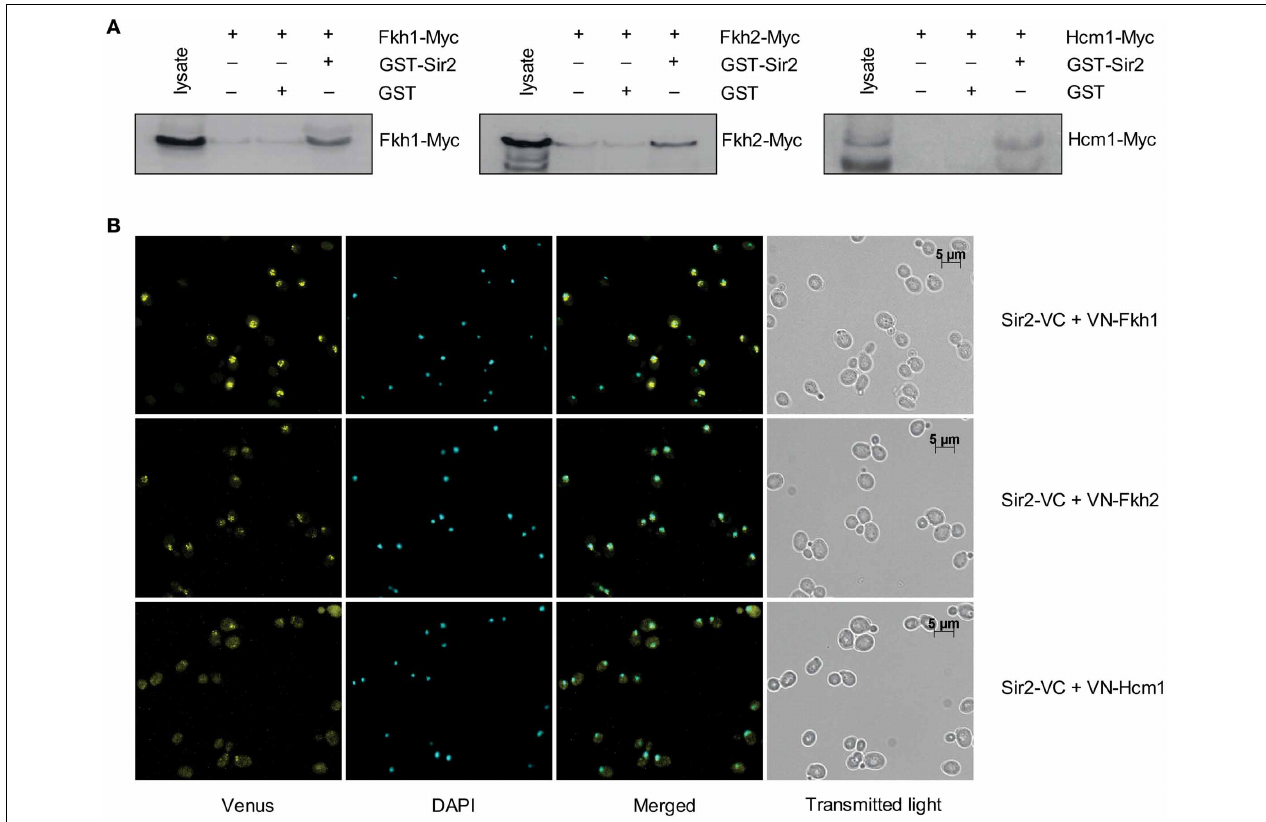
FIGURE 1 | Fkh1 and Fkh2 associate with Sir2. (A) Pull-down assay. GST and GST-Sir2 proteins expressed in E. coli were immobilized on glutathione sepharose beads and incubated with lysates derived from yeast strains carrying Myc-tagged FKH1 , FKH2, and HCM1 . Immunodetection of co-precipitated Fkh1-Myc, Fkh2-Myc and Hcm1-Myc